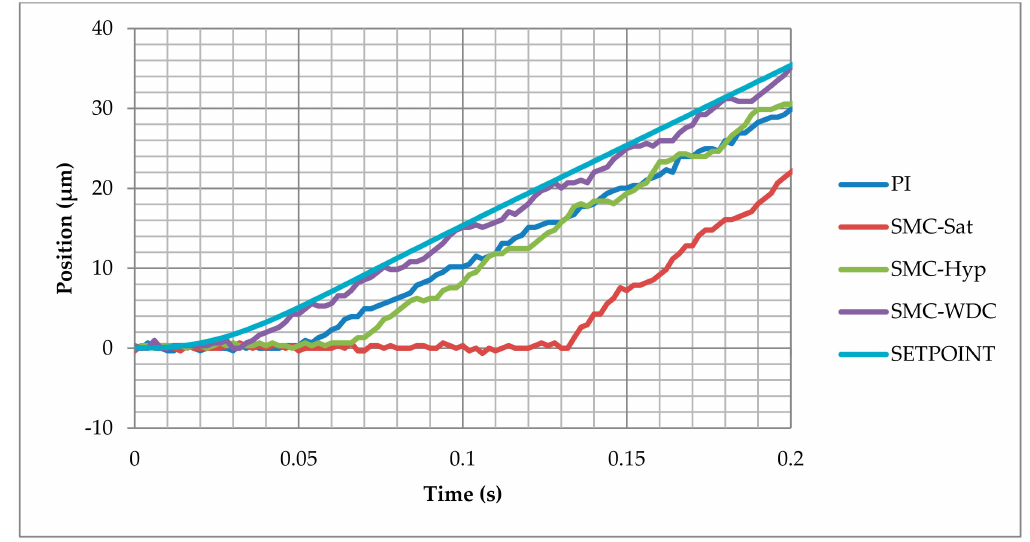
Figure 8. Response delay comparison between the di ff erent control strategies in the ramp test.